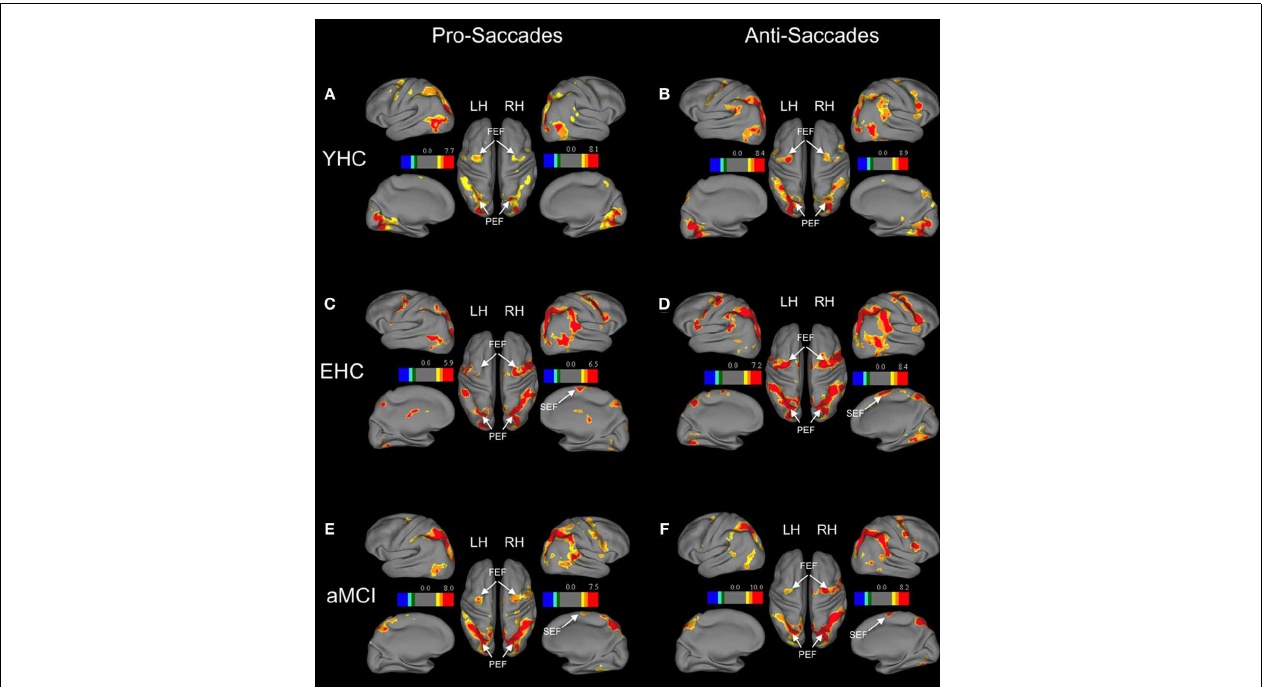
FIGURE 1 | Brain areas showing significant activation associated with pro-saccades and anti-saccades in all subject groups (contrasts: pro-saccades > baseline, anti-saccades > baseline). (Panels A,C,E ) present the results for the pro-saccade condition, whereas (Panels B,D,F ) display the results for the anti-saccade condition. Abbreviations: YHC,